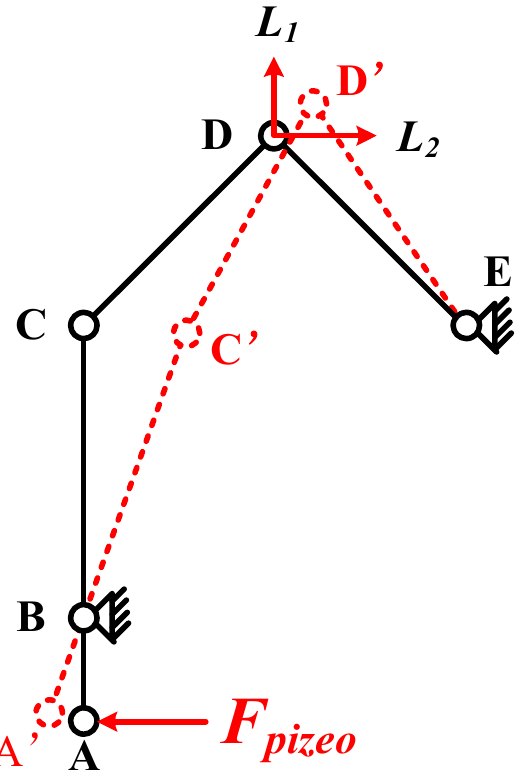
Figure 8. Kinematic model of the PEA.